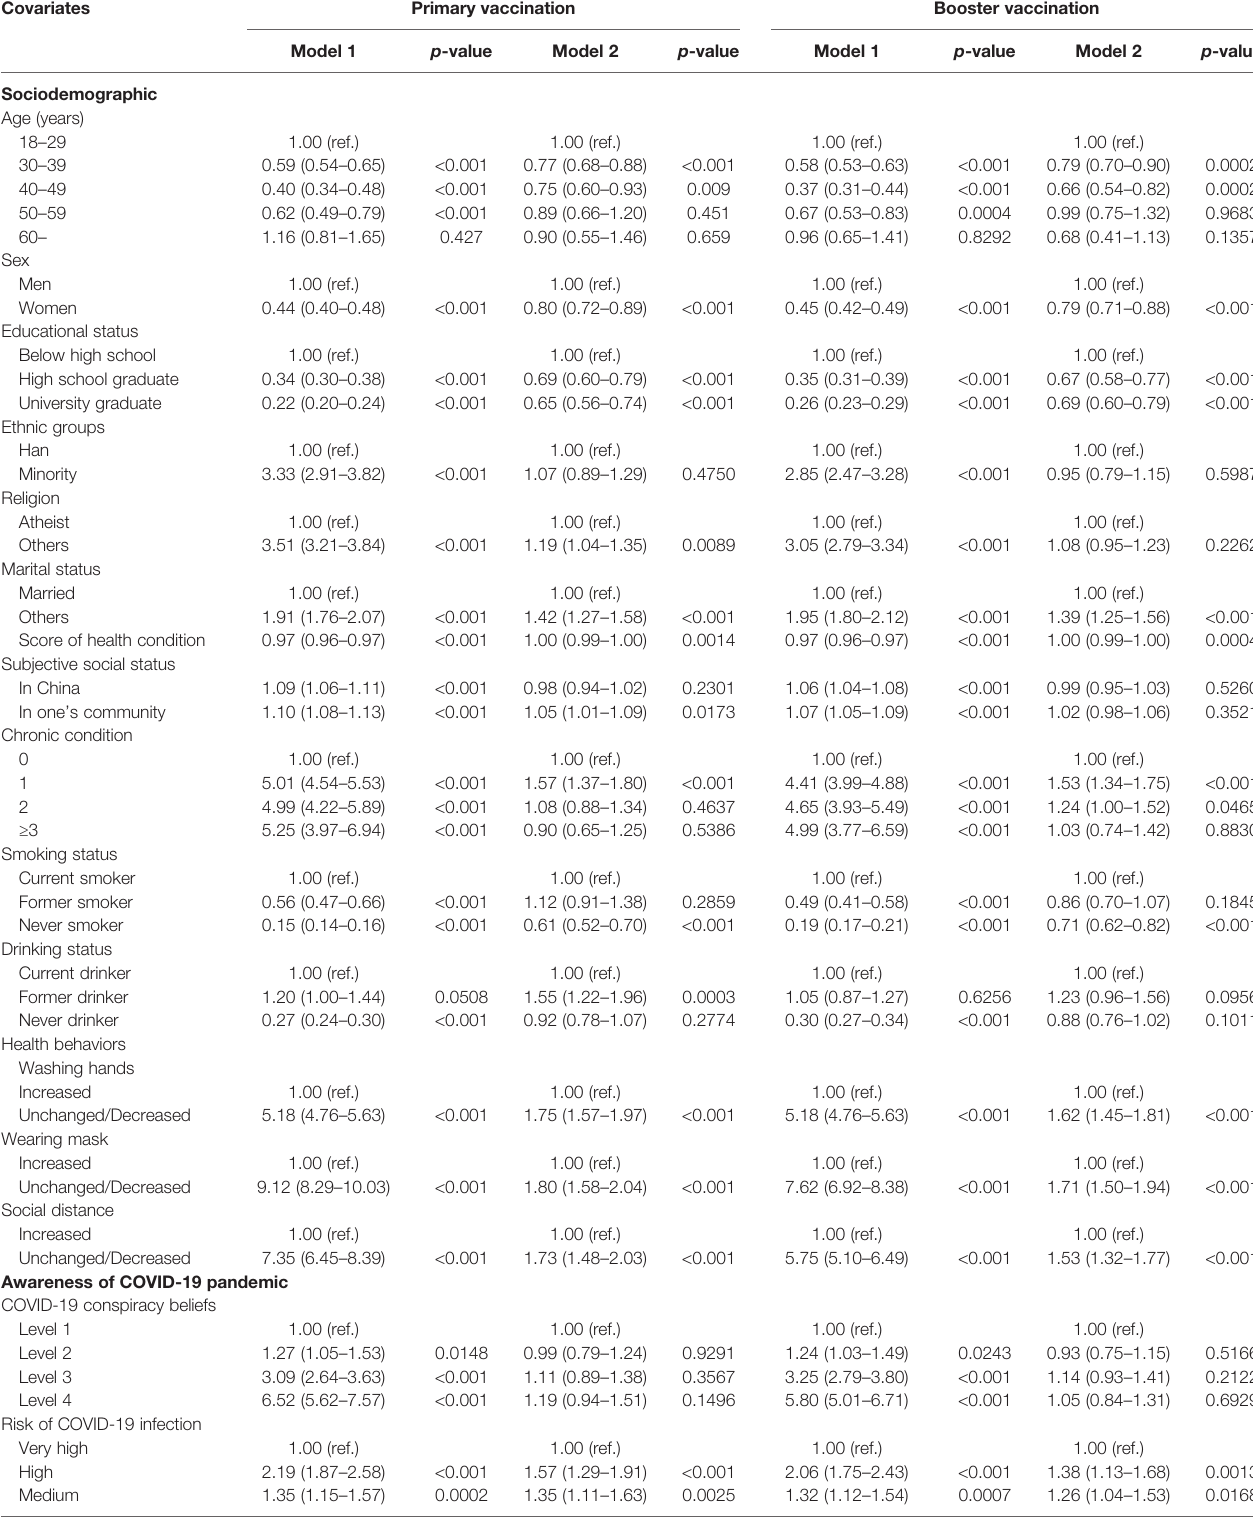
TABLE 2 | Associations between COVID-19 vaccine hesitancy and sociodemographic, awareness of COVID-19 pandemic, COVID-19 vaccine exception, and trust in healthcare system. Covariates Primary